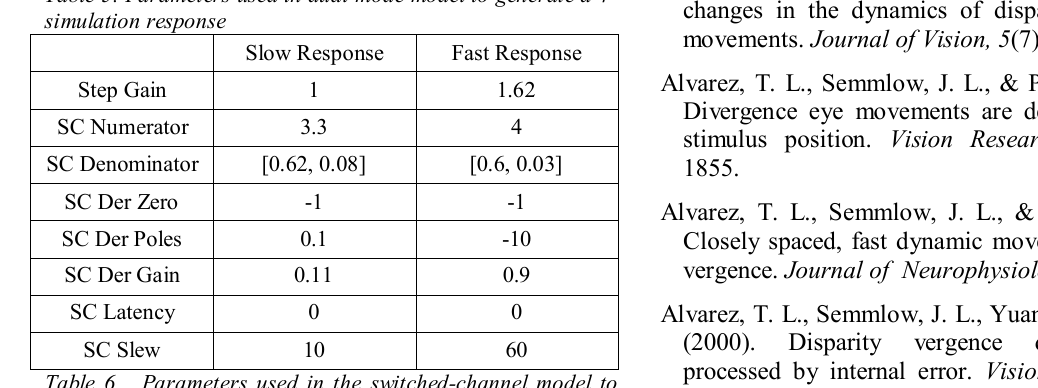
Table 6. Parameters used in the switched-channel model to generated 4  responses. Rate limiters were placed on H4 and H5 (larger disparity channels) where the rising slew rate was